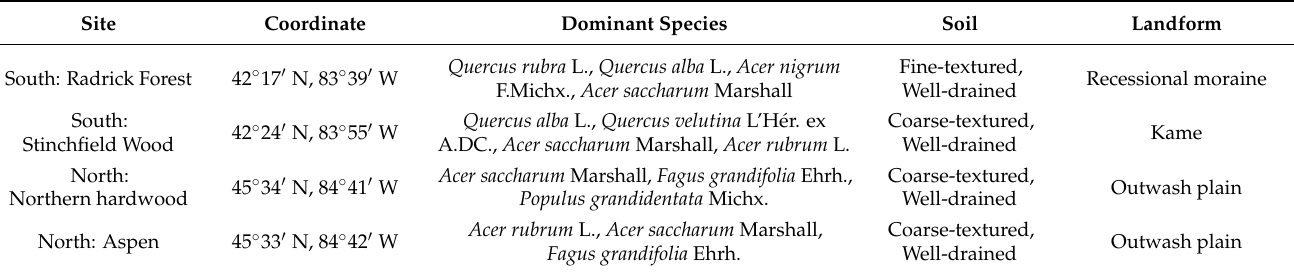
Table 1. Description of four sampling sites at the two